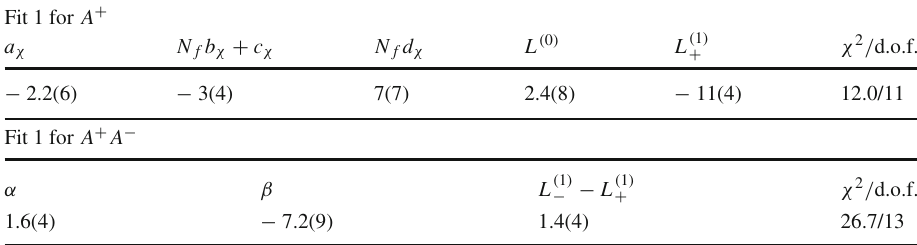
Table 6 Results for Fit 1: the simultaneous chiral and N c fits for A + and A + A − . Errors are